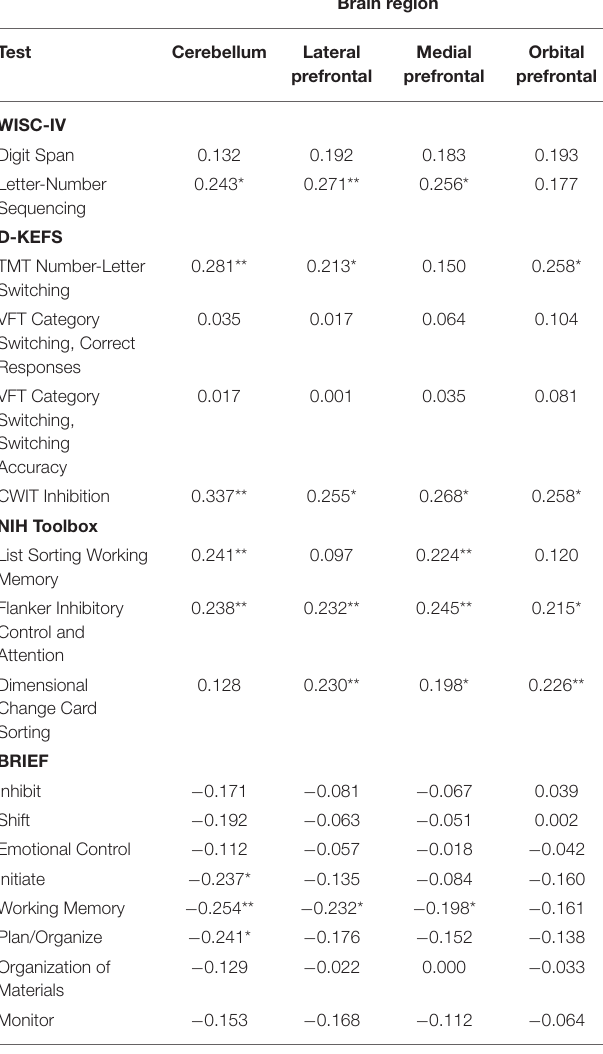
TABLE 5 | Interactive associations of cerebellar volume and prefrontal volumes with executive functioning. Test